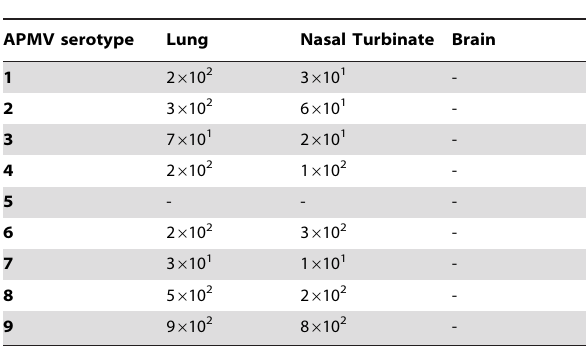
All the values are the mean of 3 mice per group. *Titers were determined by serial dilution of clarified tissue homogenates from the experiment in Table 1 onto DF1 cells, which were overlaid with methylcellulose and immunostained 4 days later with N protein-specific antisera to detect viral foci. - =no virus was